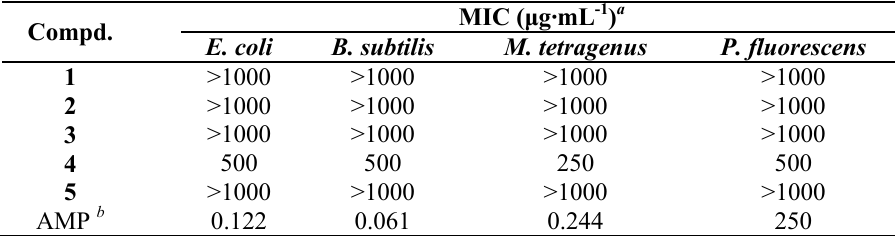
Table 2. Antibacterial Activities of Compounds 1 - 5